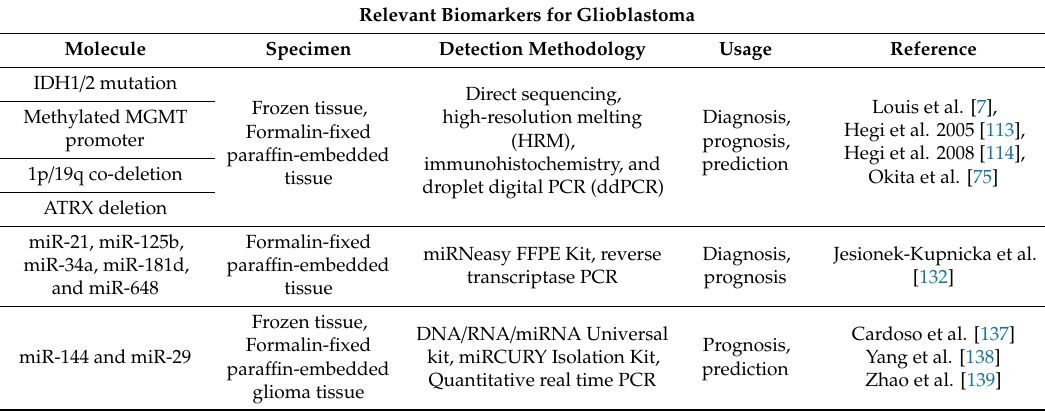
Table 2. Most used and studied biomarkers for